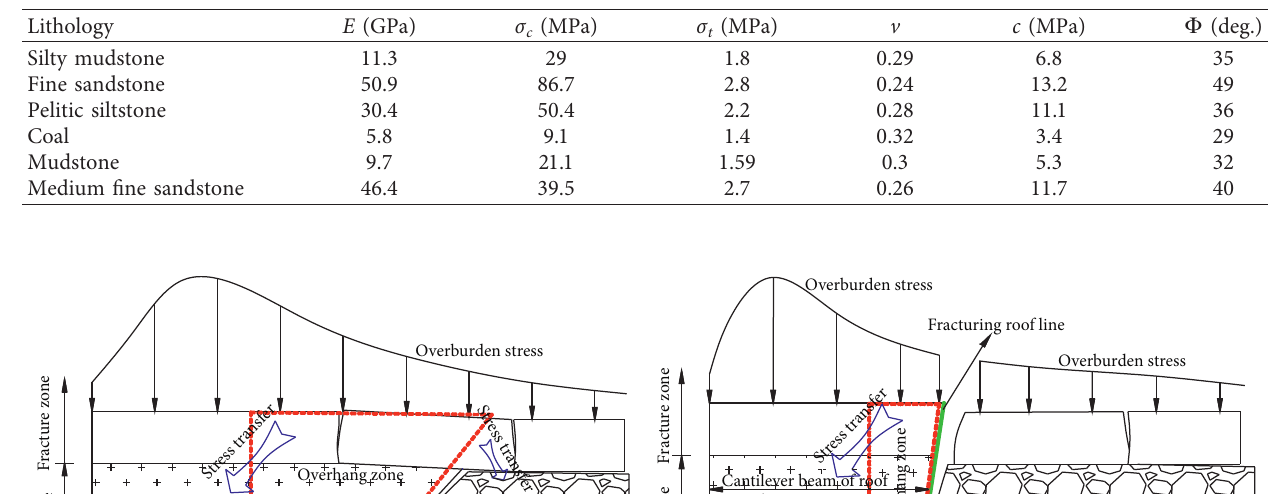
Figure 5: Rock and coal samples. Table 2: Mechanical parameters of coal and rock.